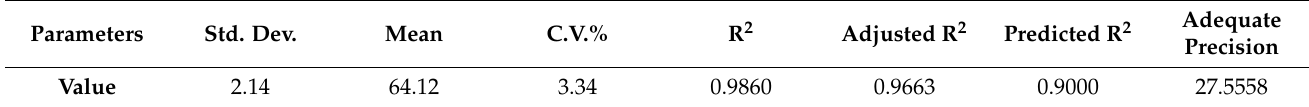
Table 8. Basic statistical parameters for the selected reduced cubic